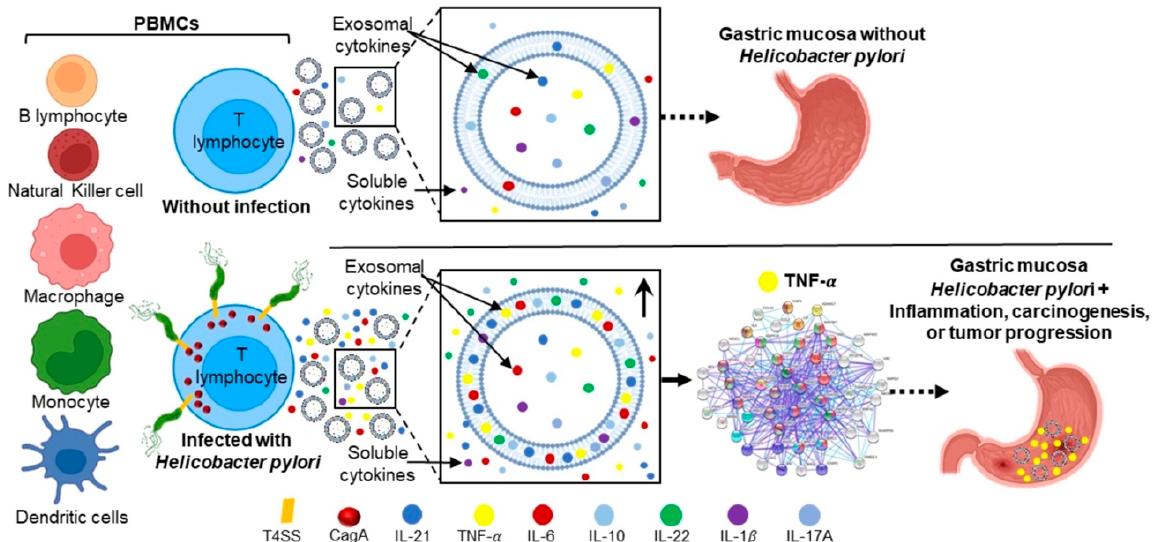
Figure 5. H. pylori promotes the secretion of exosomal and soluble cytokines that are associated with inflammation and gastric carcinogenesis. H. pylori adheres PBMCs and translocates CagA to the cell cytoplasm. In infected PBMCs, H. pylori promotes the secretion of IL-1 β , IL-6, TNF- α , IL-10, IL-17A, IL-21, and IL-22. TNF- α could play an important role in the activation of signaling pathways that are associated with inflammation, gastric carcinogenesis, or tumor progression. Supplementary Materials: The supporting information